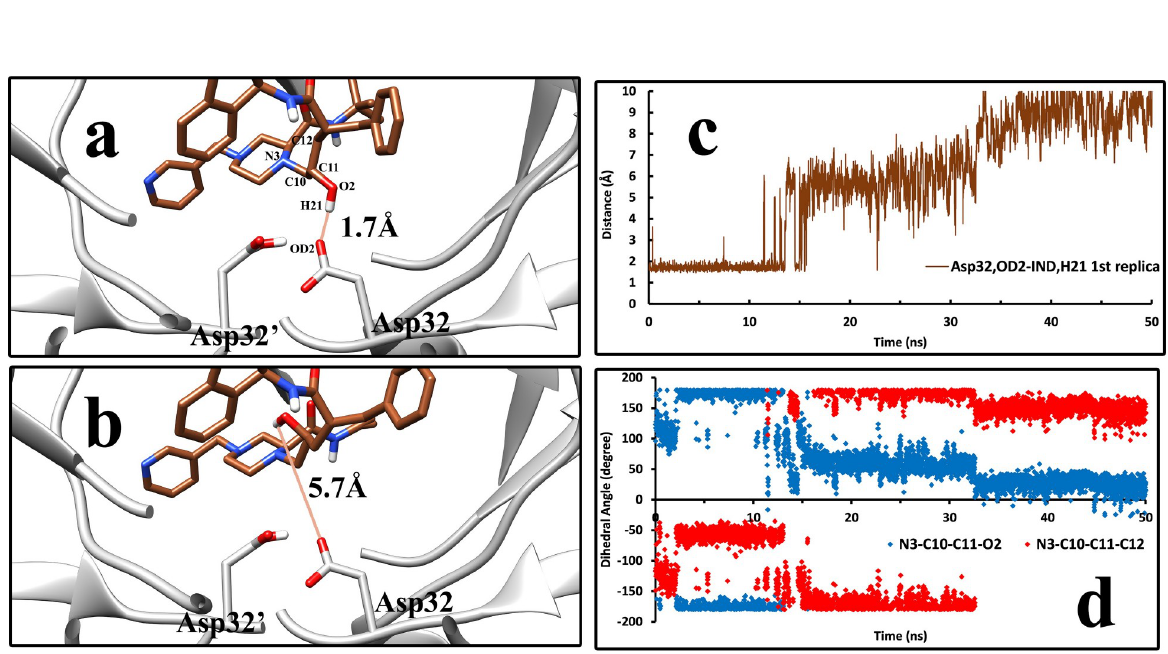
Fig 8. The first step of the unbinding pathway of Indinavir. a, Indinavir in the native state where a hydrogen bond with the Asp32 in the HTLV- 1 protease keeps it stable in this state. b, the breakage of the hydrogen bond, which triggers the unbinding pathway. Both figures are frames 1153 and 1154, showing that this event needs very little time to happen. c , The distance between the OD 2 atom of Asp32 and the H 21 atom of Indinavir in the first 50 ns of the unbinding pathway of Indinavir-HTLV-1 complex in the 1 st replica. d, The dihedral angles of the rotatable bond responsible for the rotation of the hydroxyl group of Indinavir in the first 50 ns of the unbinding pathway of Indinavir-HTLV-1 complex in the 1 st replica.